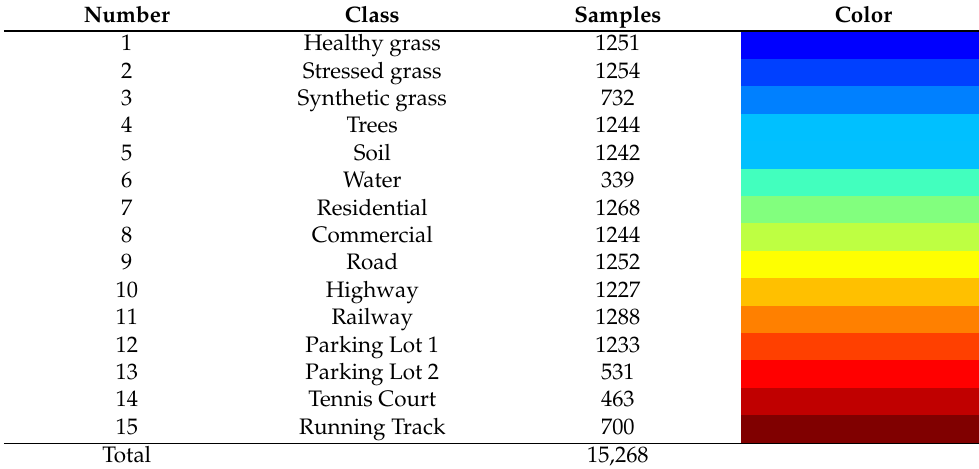
Table 5. The information of each class in